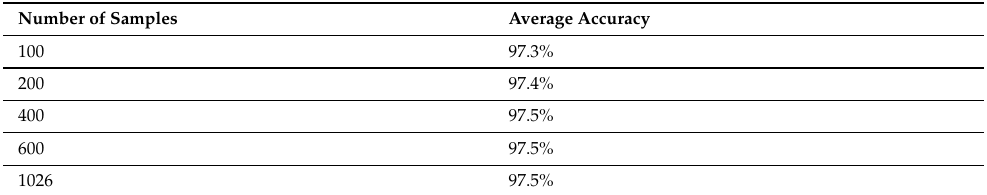
Table 4. Accuracy tests of the DCARE model.